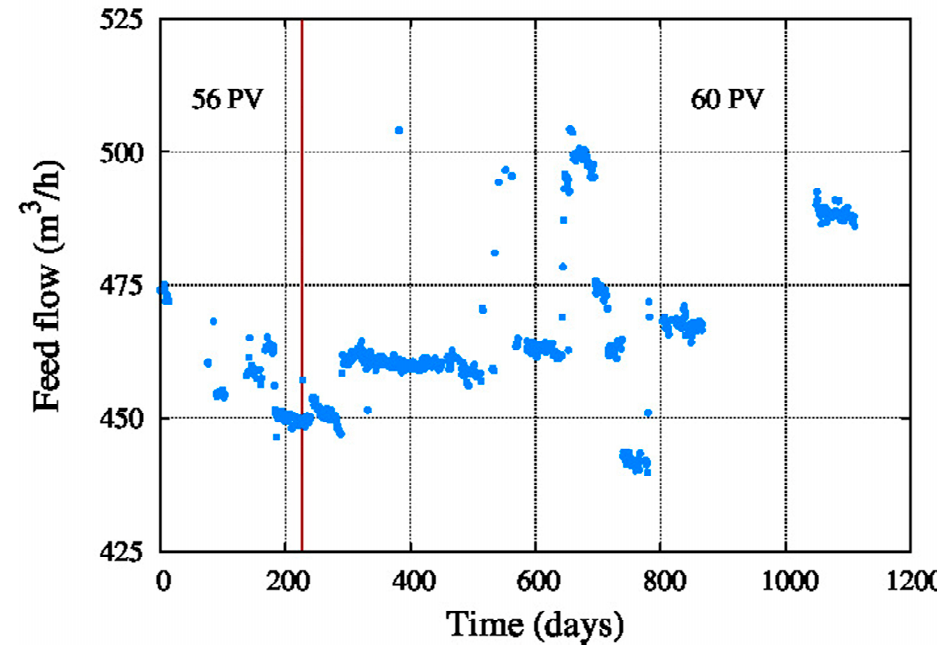
Figure 5. Feed flow.